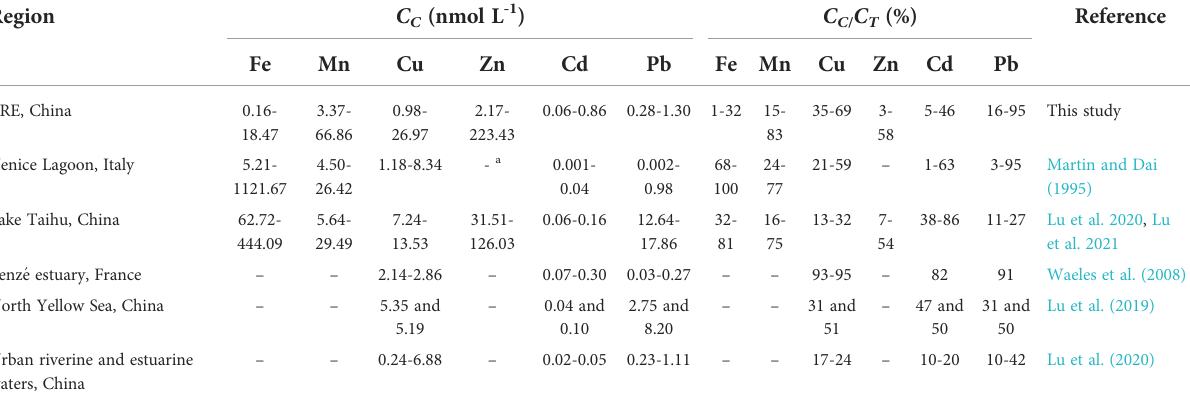
TABLE 3 A comparison of the colloidal metal data in this study and the other literature. C C and C T represent the concentrations of the colloidal phase and TD phase, respectively. Region